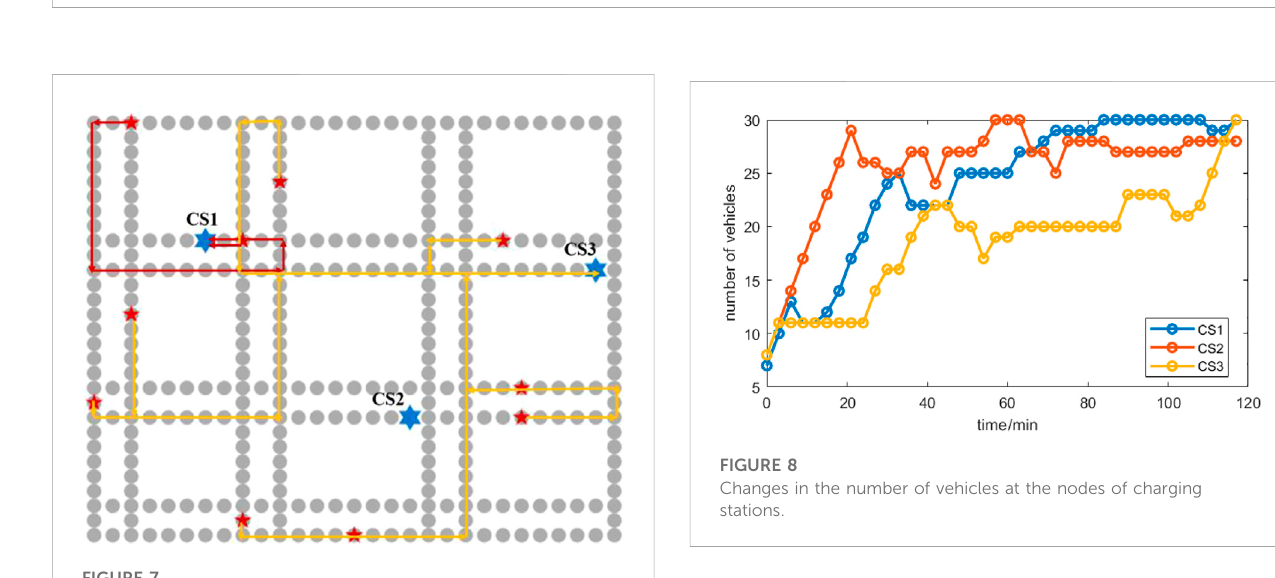
FIGURE 7 Co-navigation process for 10 discharging EVs.